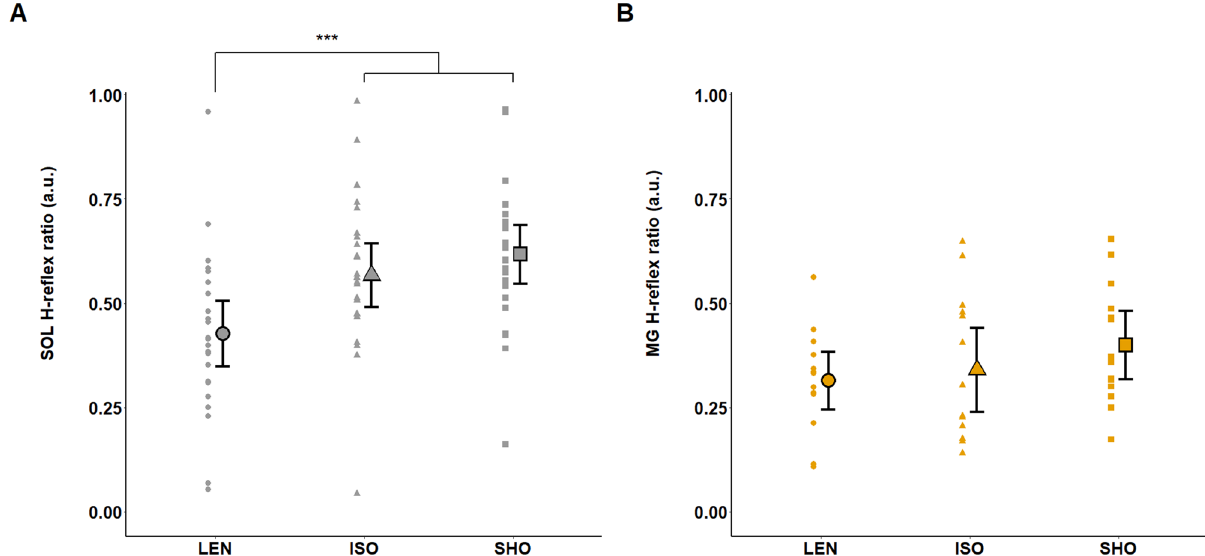
Figure 2. Effects of muscle contraction type on the soleus and the medialis gastrocnemius spinal excitability. Modulations of spinal excitability are computed with the muscle H-reflex (H sup ) normalized to the corresponding M-wave (M sup ) amplitudes, in arbitrary units (a.u). Modulations of the H sup /M sup ratio for ( A ) the soleus (n = 25) and ( B ) the medialis gastrocnemius (n = 14) are shown during lengthening (LEN), isometric (ISO) and shortening (SHO) contractions. Error bars represent the 95% CI of the mean. Lengthening vs isometric and shortening: ***p <